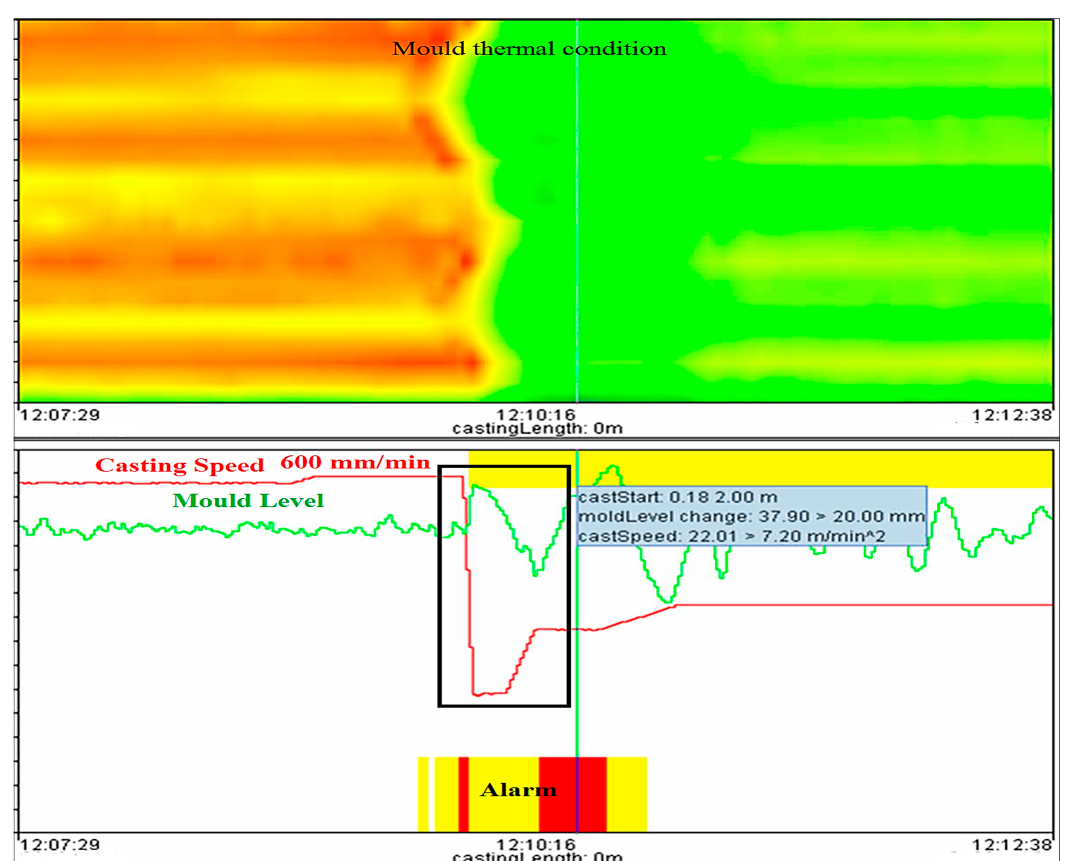
Figure 12. Breakout alarm due to variation in casting speed during unstable casting condition.